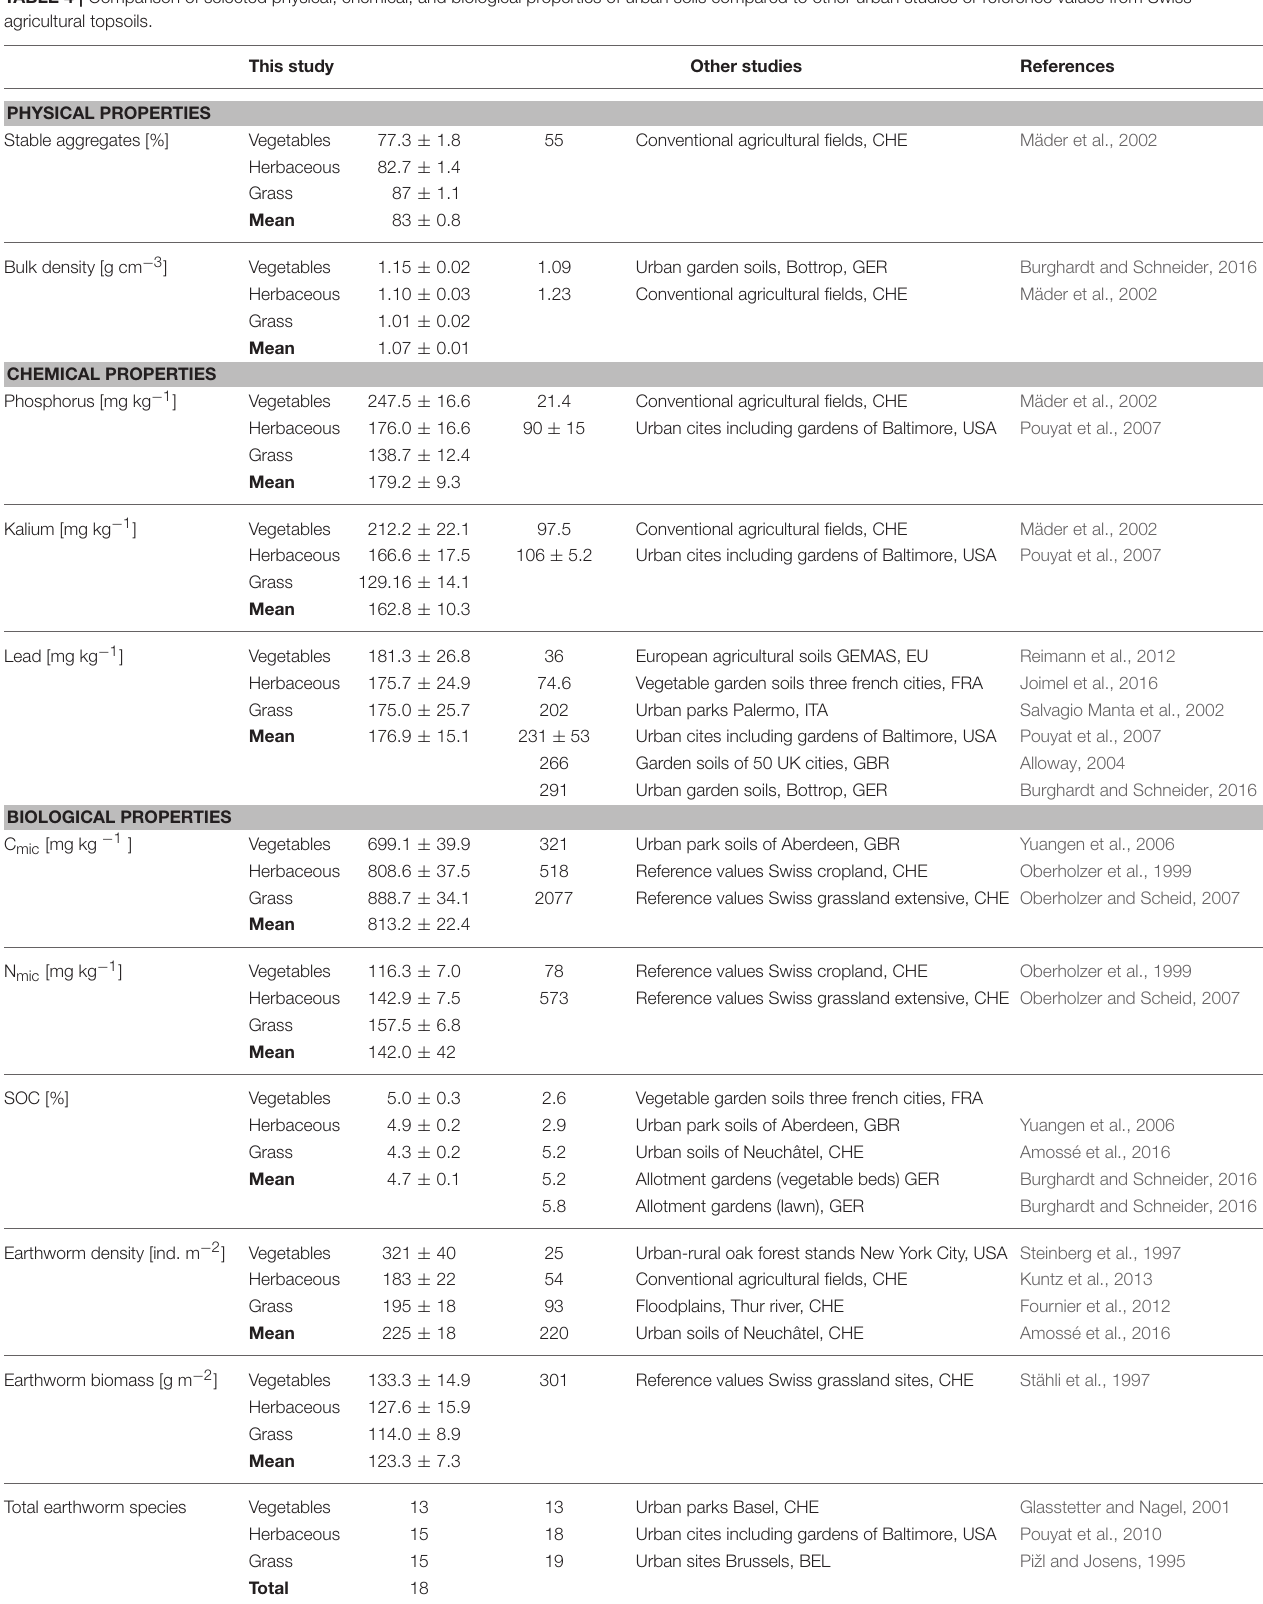
TABLE 4 | Comparison of selected physical, chemical, and biological properties of urban soils compared to other urban studies or reference values from Swiss agricultural topsoils. This